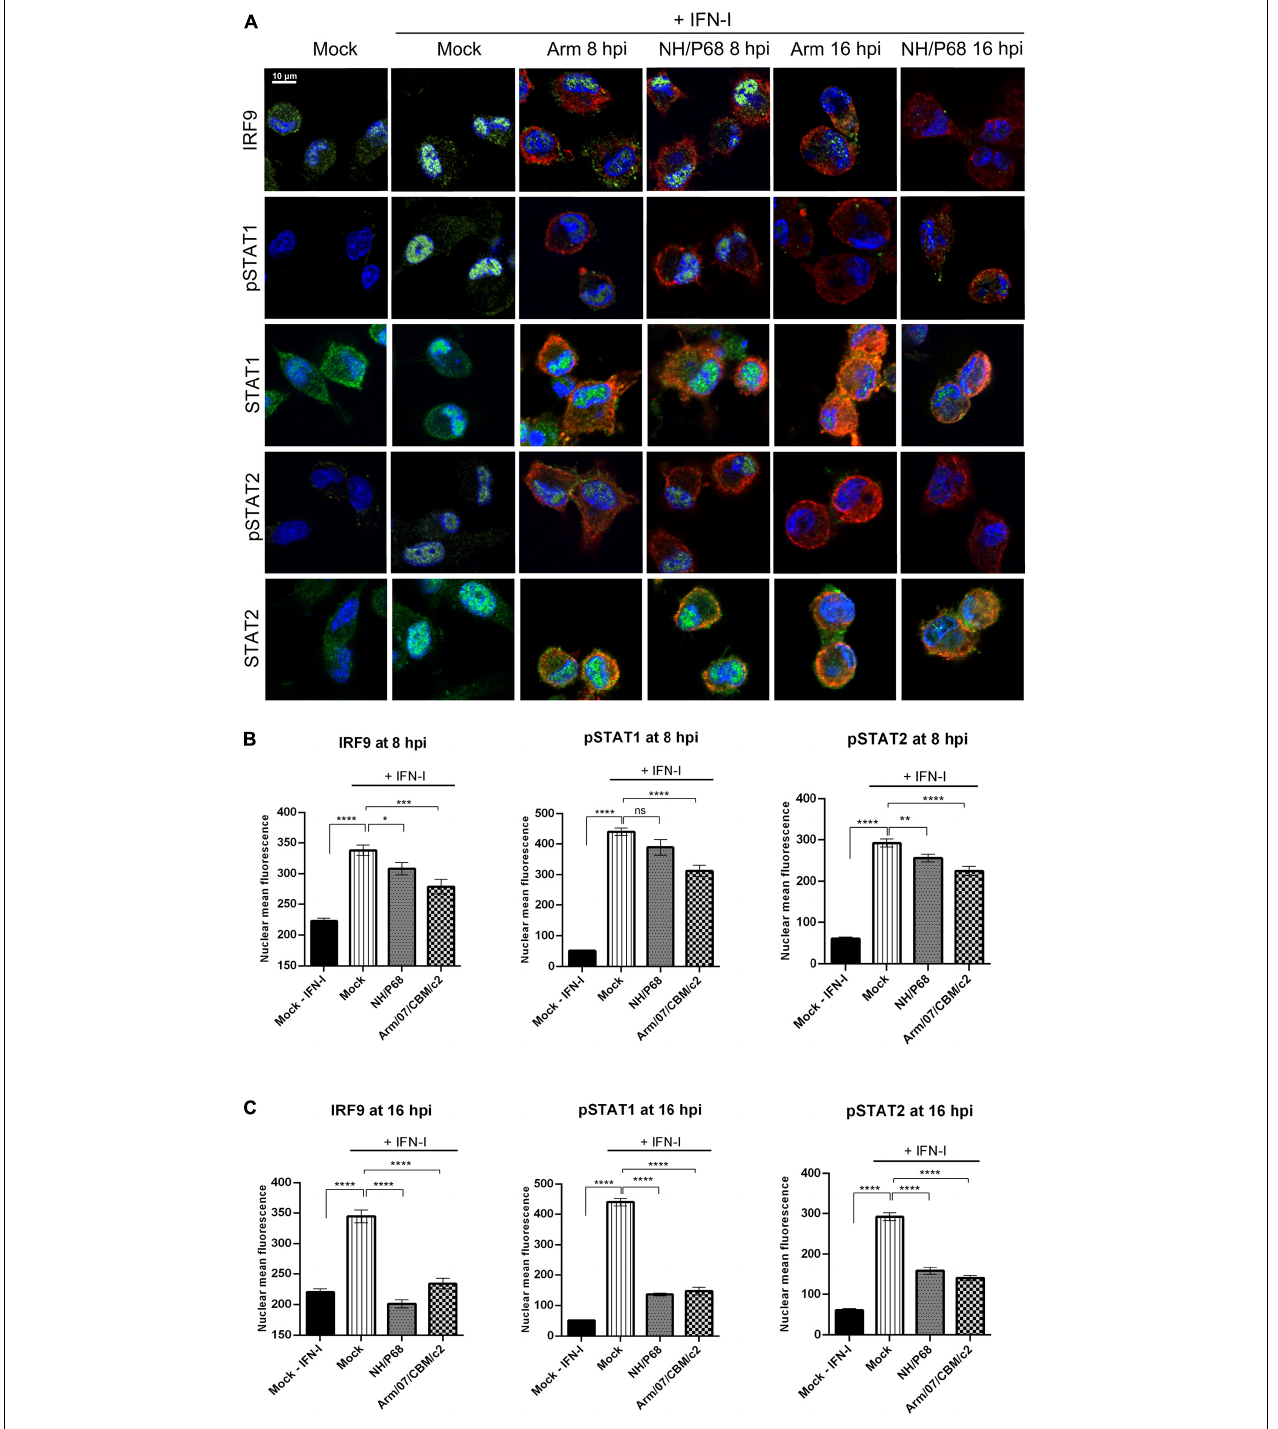
FIGURE 2 | NH/P68 and Arm/07/CBM/c2 strains interfere with ISGF3 nuclear translocation and inhibits STAT1 and STAT2 phosphorylation at late times of infection. PAMs were mock infected or infected with NH/P68 or Armenia/07/CBM/c2 (Arm) (1 PFU/cell). At 7 or 15 hpi, cells were untreated or treated with universal type I IFN (250 U/ml). After 1 h of treatment, cells were fixed and stained with DAPI (blue), anti-IRF9/anti-pSTAT1/anti-STAT1/anti-pSTAT2/anti-STAT2 (green) and anti-p32 (red) antibodies and examined by a confocal microscope. Merged images of the different channels are shown (A) . The nuclear mean fluorescence of mock infected cells or infected cells (p32 labeled) at 8 hpi (B) or at 16 hpi (C) was measured using Image J software. The nuclear mean fluorescence of IRF9, pSTAT1 or pSTAT2 was calculated among 70–100 cells per condition of three biological replicates. All data are means ± SEM. Data were statistically analyzed by using a Student t test (*, P < 0.05; **, P < 0.01; ***, P < 0. 001; ****, P <